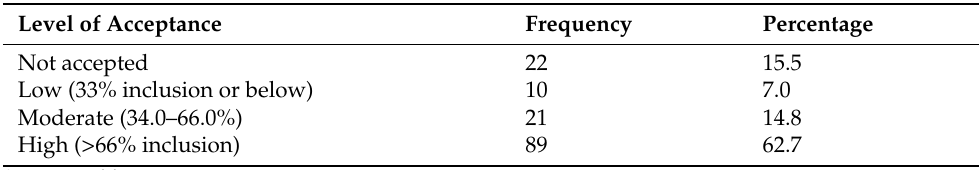
Table 4. Distribution of respondents’ acceptance (willingness to adopt) of BSF as a source of protein for poultry feed among farmers.